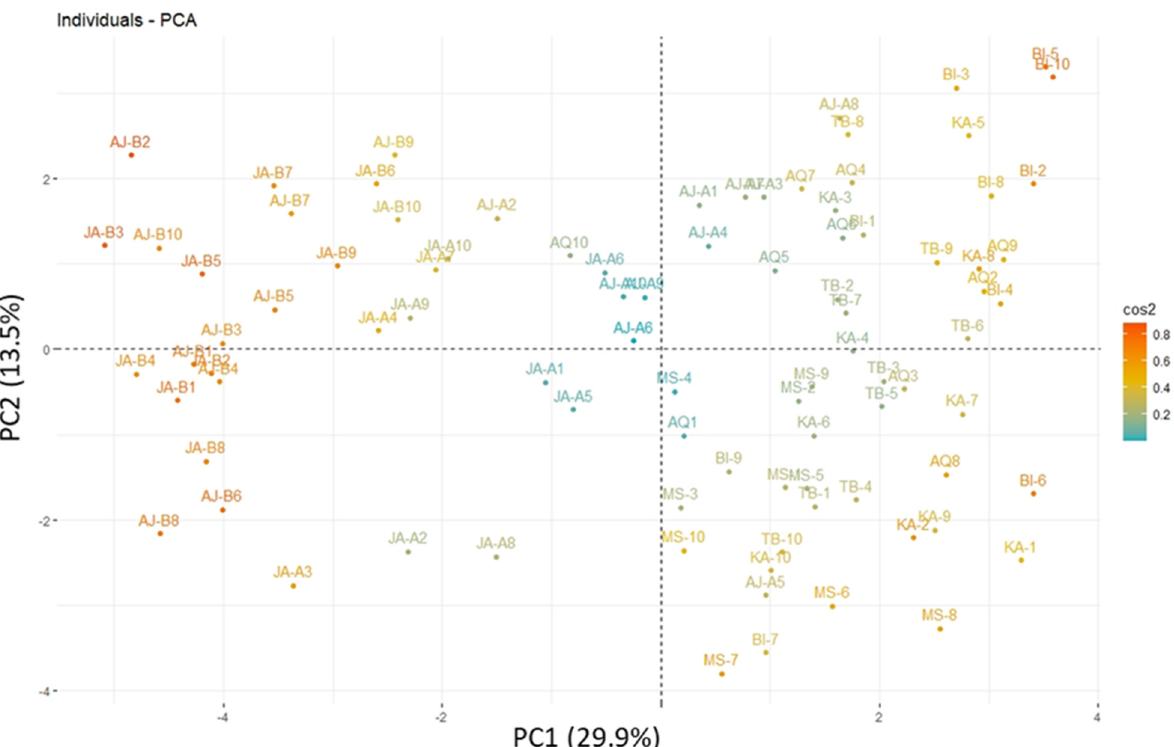
Figure 2. Plot of the first and second principal components based on the morphological traits of 90 individuals of R. chalepensis collected from northern Jordan. (BI: Beit Idis, MS: Massom, KA: Kofer Assad, AQ: Aqraba, TB: Taibeh, AJ-A: Ajloun-A, AJ-B: Ajloun-B, JA-A: Jarash-A and JA-B: Jarash-B). Cos2: quality of the representation of individuals based on the principal components.